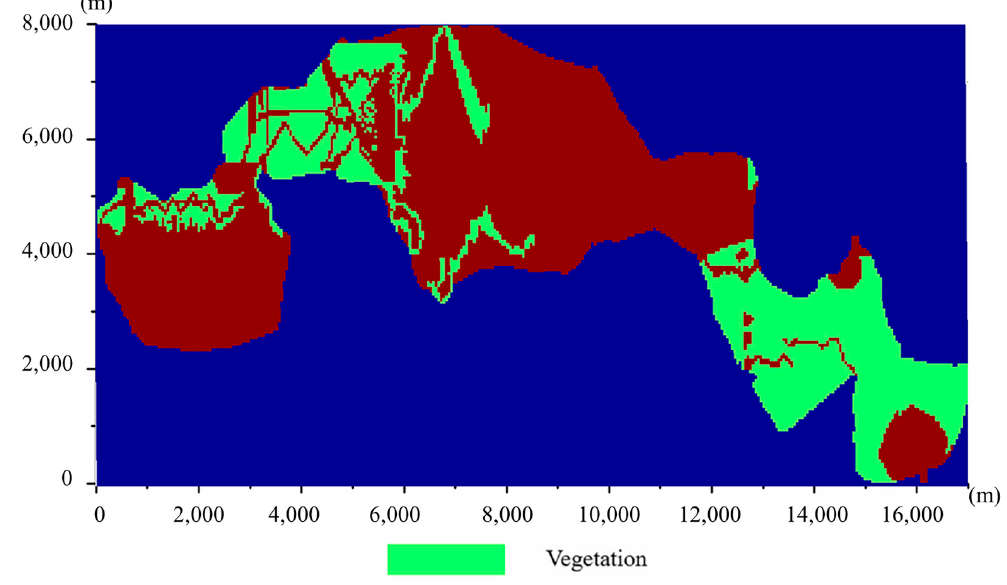
Figure 5. Vegetation distribution in Baihe Lake.